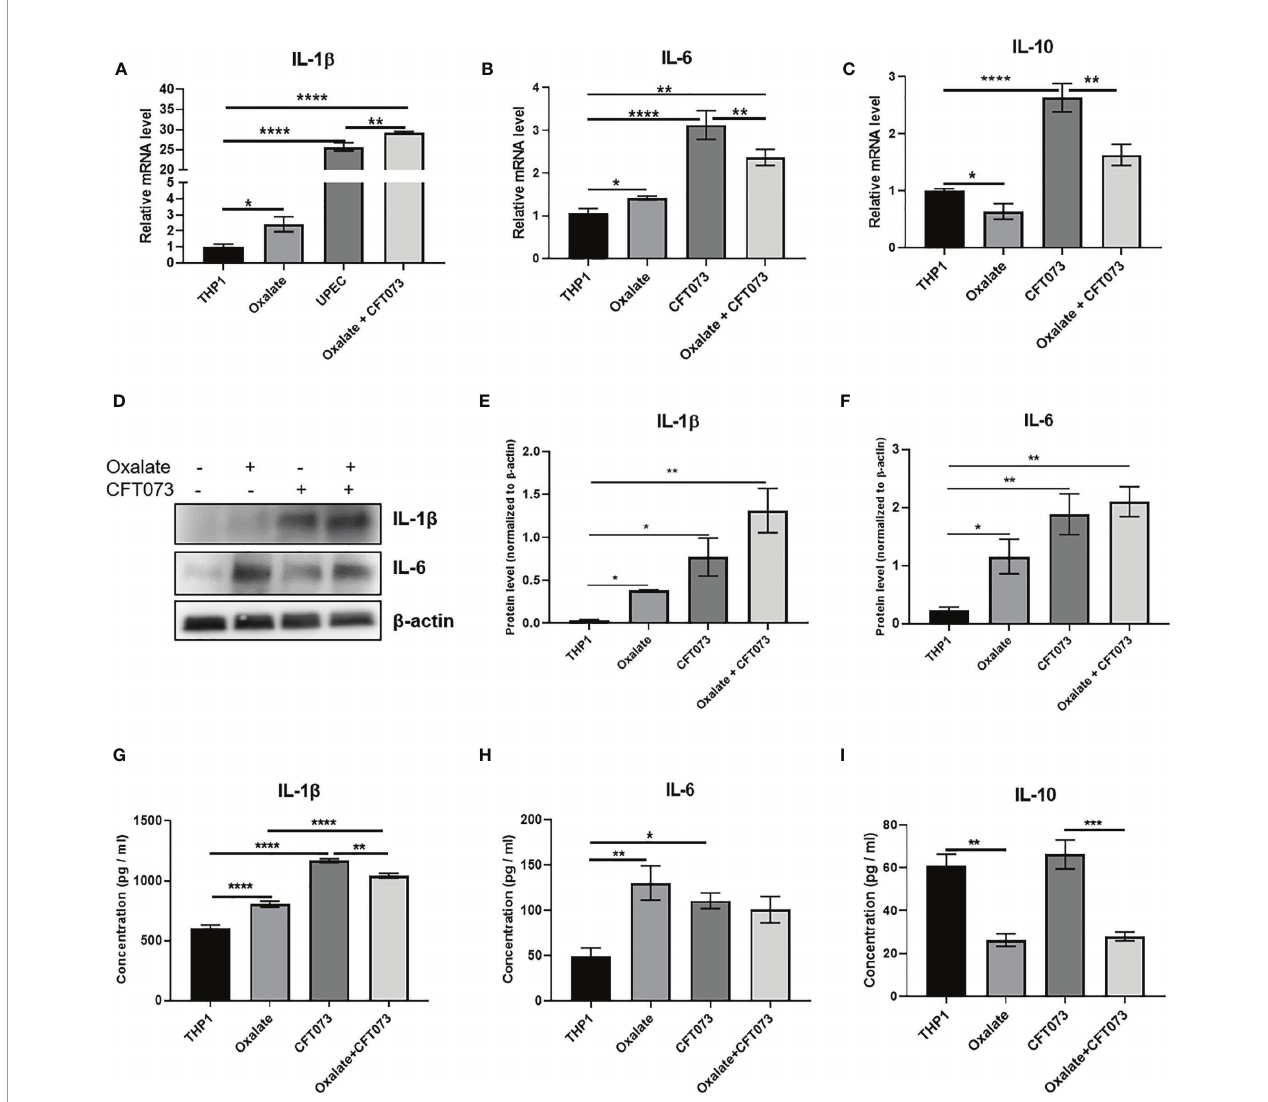
FIGURE 5 | Oxalate increases pro-in fl ammatory cytokine expression and secretion but reduces anti-in fl ammatory cytokine expression and secretion in THP-1 macrophages. THP-1 macrophages were exposed to oxalate with or without CFT073 (MOI 1:2) as described in the Materials and Methods section. Gene expression of (A) IL-1 b (pro-in fl ammatory cytokine), (B) IL-6 (pro-in fl ammatory cytokine), and (C) IL-10 (anti-in fl ammatory cytokine) using qRT-PCR. (D) Western blot analysis and (E, F) quanti fi cation of IL-6 and IL-1 b levels using ImageJ software. Cytokine secretion of (G) IL-1 b , (H) IL-6, and (I) IL-10, respectively. All experiments were performed at least three times with n=5 replicates. Data are expressed as mean ± SEM. *p < 0.05, **p < 0.01, ***p < 0.001, ****p < 0.0001 is signi fi cant compared to control THP-1 macrophages or CFT073